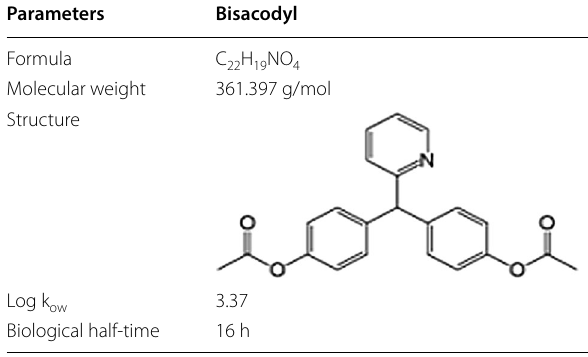
Table 1 Physical and chemical properties of bisacodyl